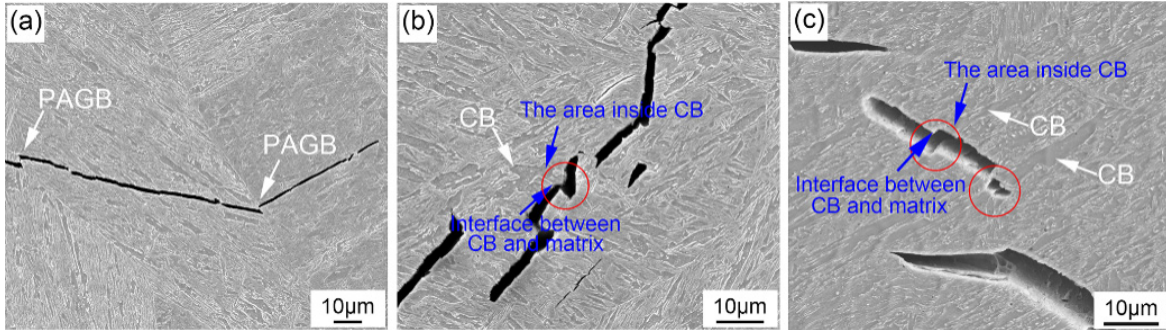
Figure 15. The second crack propagation path images of impact fracture specimens at − 60 °C; ( a ) Ni5.5, ( b ) Ni6.5, and ( c ) Ni7.5.